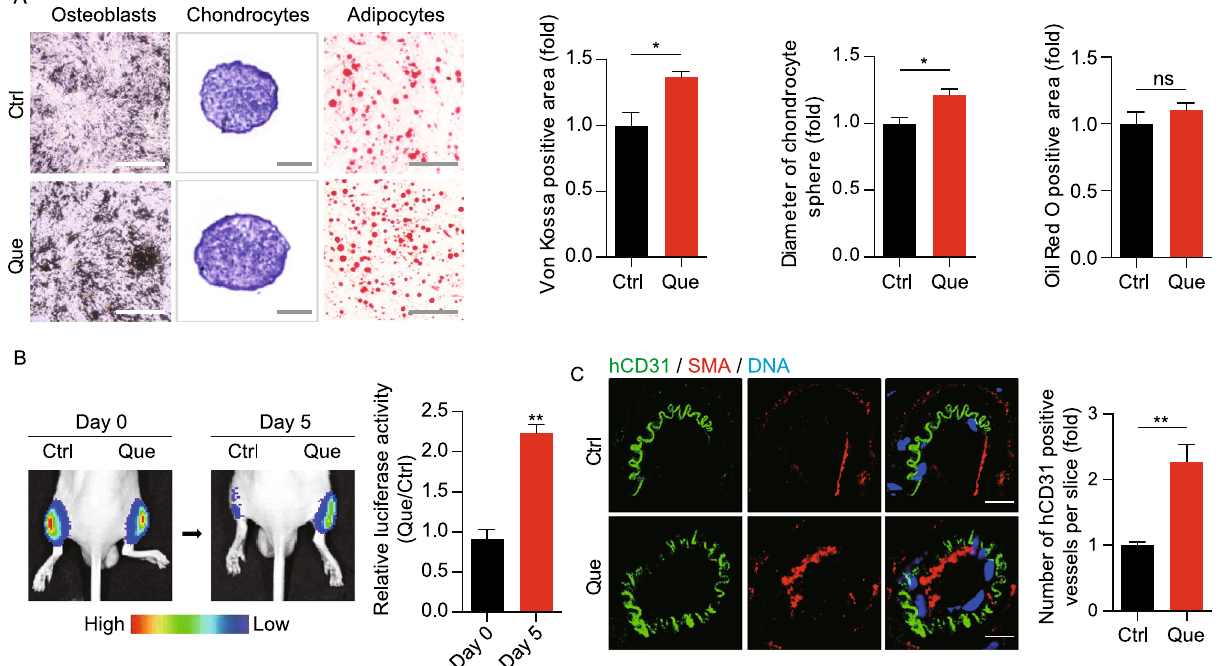
Figure 4. Que promoted cellular differentiation and vasculogenesis of WS hMSCs. (A) Characterization of osteogenesis, chondrogenesis and adipogenesis potentials of vehicle- and Que-treated WS hMSCs (passage 7) stained by Von Kossa ( n = 3 independent experiments), toluidine blue O ( n = 15 spheres) and oil red O ( n = 3 independent experiments), respectively. Data are presented as mean ± SEM. * P < 0.05 vs. Ctrl; ns, not signi fi cant. Scale bar, 100 μ m. (B) In vivo hMSC implantation assay with vehicle- and Que-treated WS hMSCs. Quantitative data on the right are presented as mean ± SEM. ** P < 0.01 vs. Ctrl ( n = 6). (C) Fat pad transplantation with vehicle- and Que-treated WS hMSCs (passage 7). Left: representative immuno fl uorescent images showing neovascularization; right: the number of hCD31-positive vessels calculated based on 20 slices from inconsecutive frozen sections from six mice each group. ** P < 0.01 vs. Ctrl. Scale bar, 10 μ